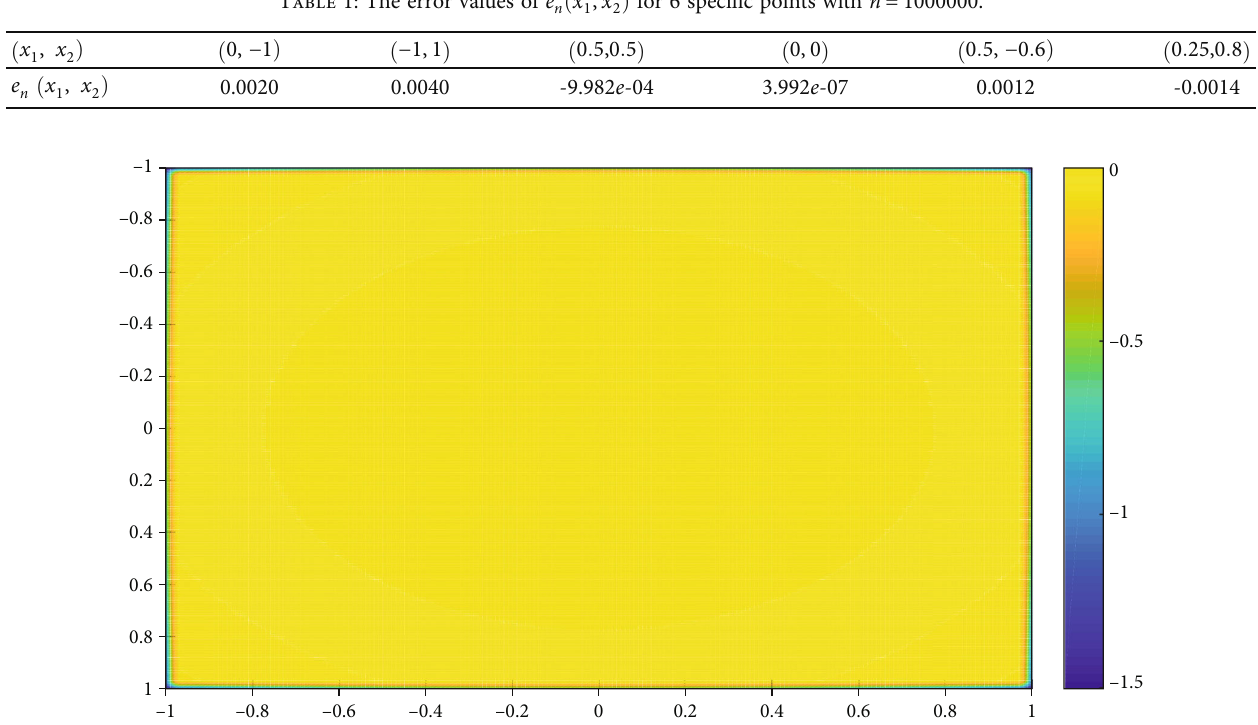
Figure 4: Errors of approximation of network operators (53) with n = 1000